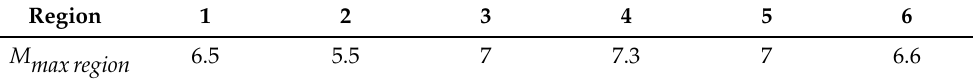
Table 1. Maximal magnitude M maxregion of each region. Region numbers refer to Figure 4.